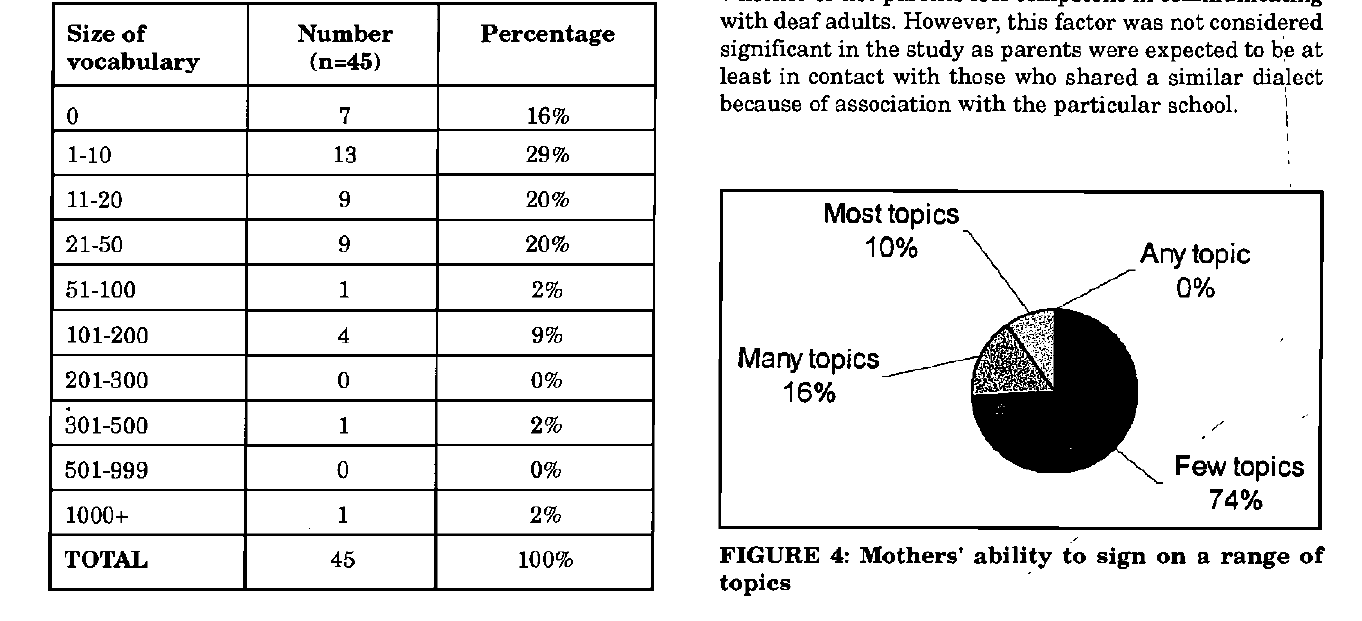
FIGURE 4: Mothers' ability to sign on a range